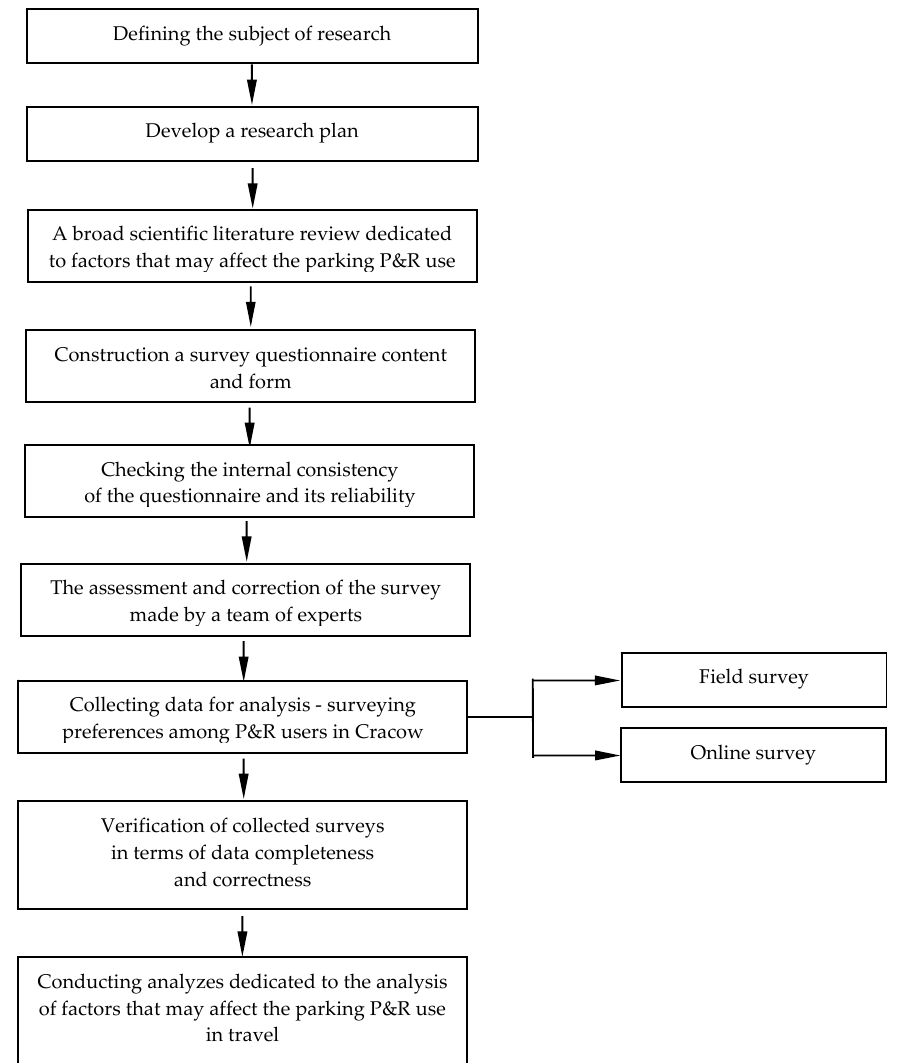
Figure 7. The research algorithm for the analysis of factors that may affect the P&R parking use.